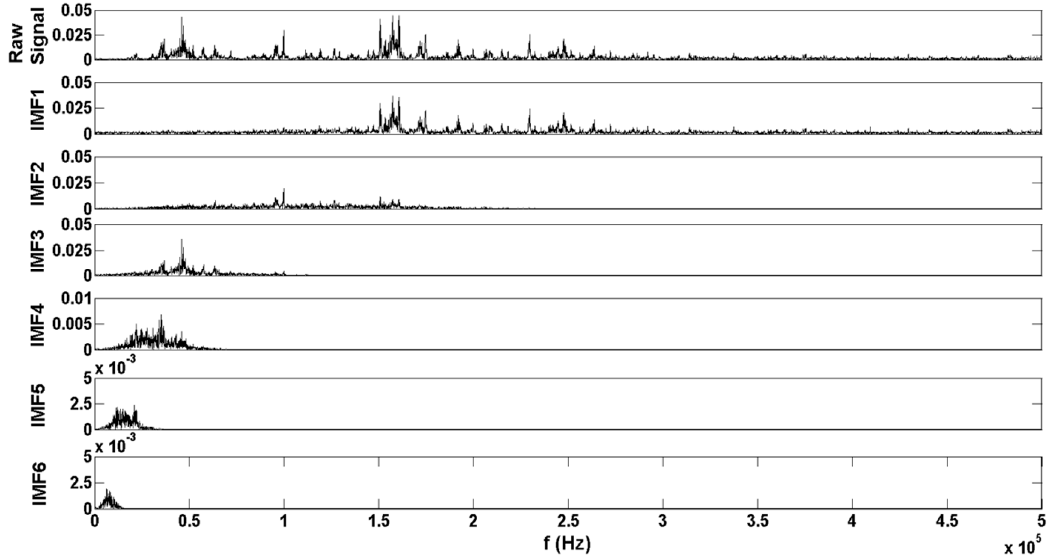
Figure 10. Raw signal and a portion of the intrinsic mode functions (IMFs) in the frequency